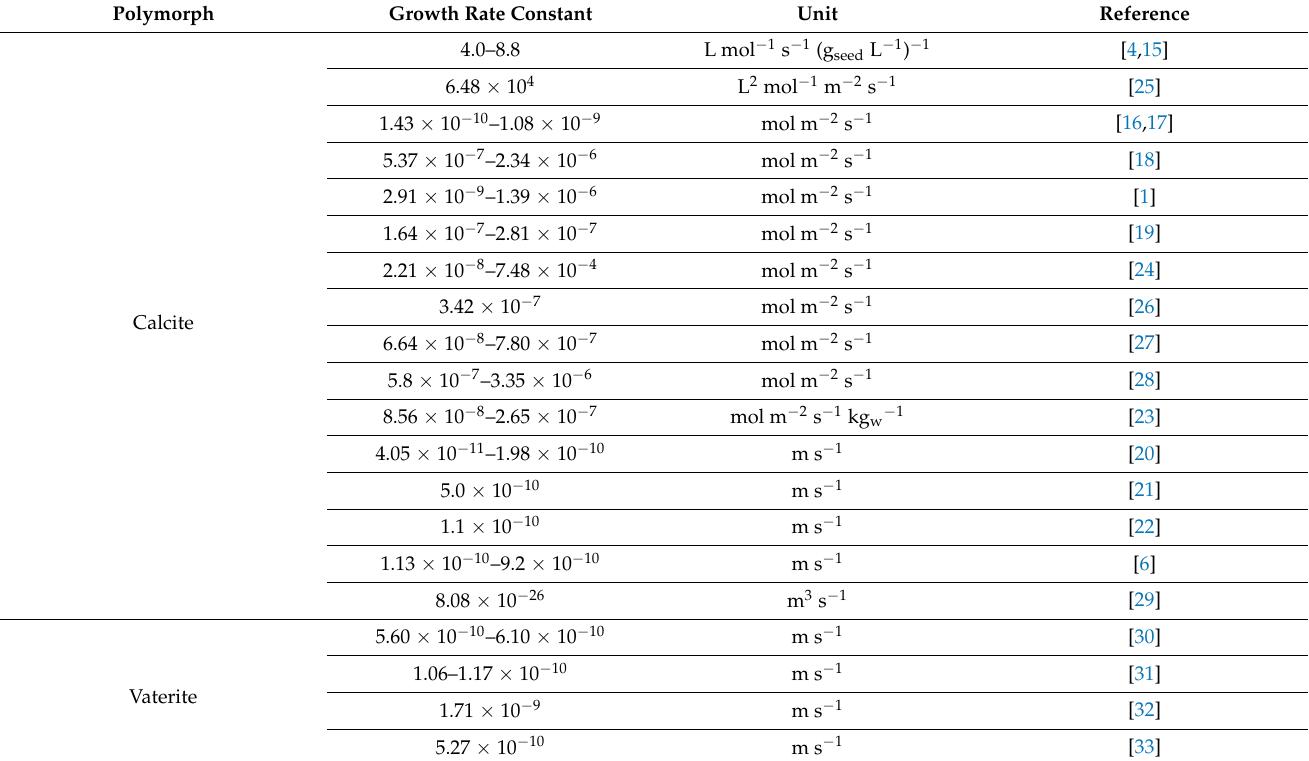
Table 1. Reported growth rate constants in the